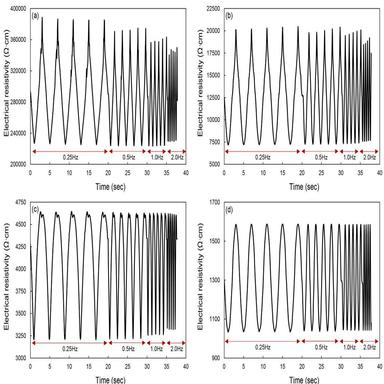
Electrical resistivity change of the samples with TWCNT content of (a) 0.1, (b) 0.2, (c) 0.3, and (d) 0.5% under the dynamic compressive loadings with various loading frequencies.